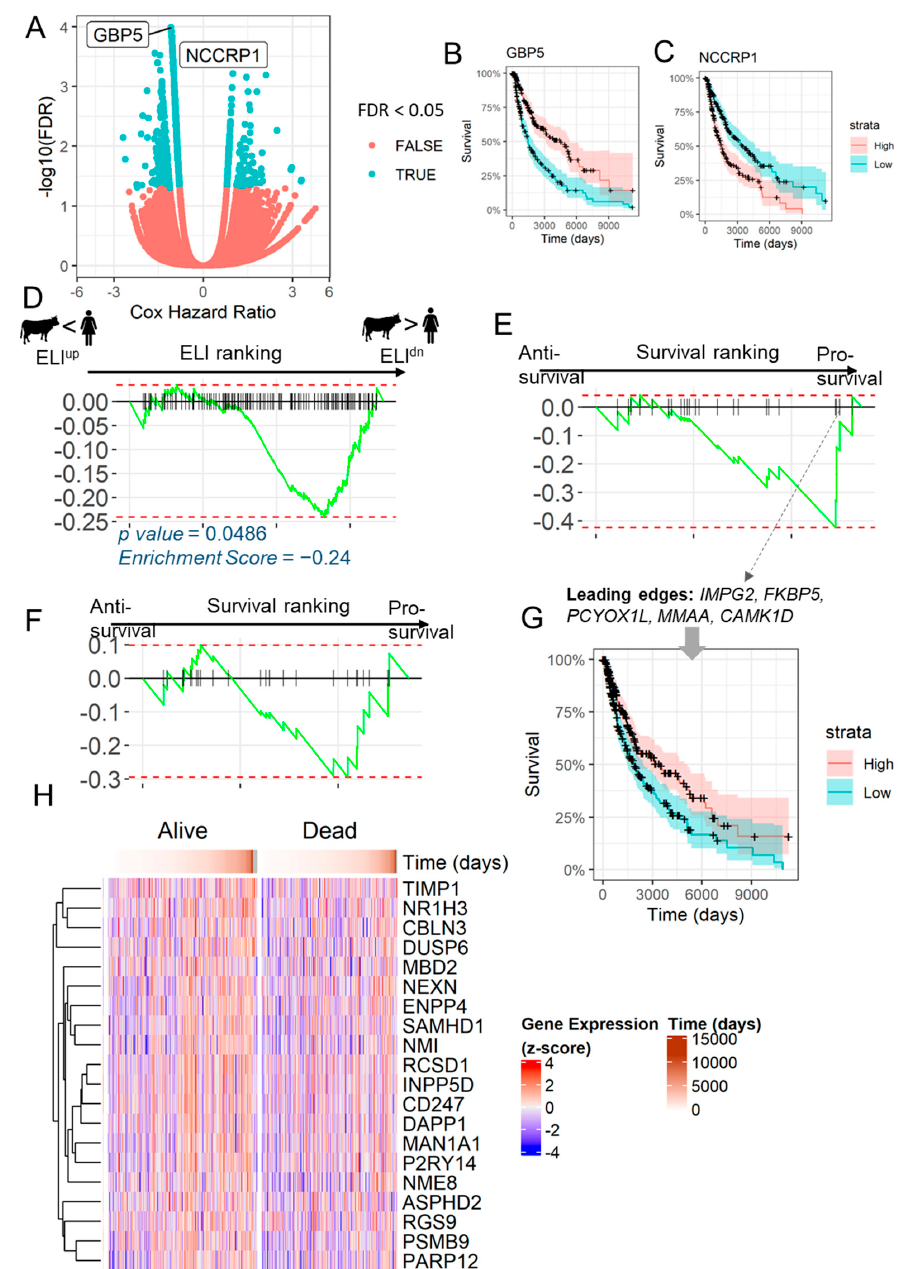
Figure 2. Gene-wise survival analysis reveals positive prognosis for ELI dn genes in melanoma. ( A ) All genes were tested for their effect on survival using the Cox proportional hazard test, using patient data from TCGA’s SKCM project. Shown are the statistical significance ( y -axis) and the hazard ratio ( x -axis) for individual genes. Genes are colored by their false discovery rate (FDR). ( B , C ) Effect on survivability for the most significant pro-survival (GBP5) and anti-survival